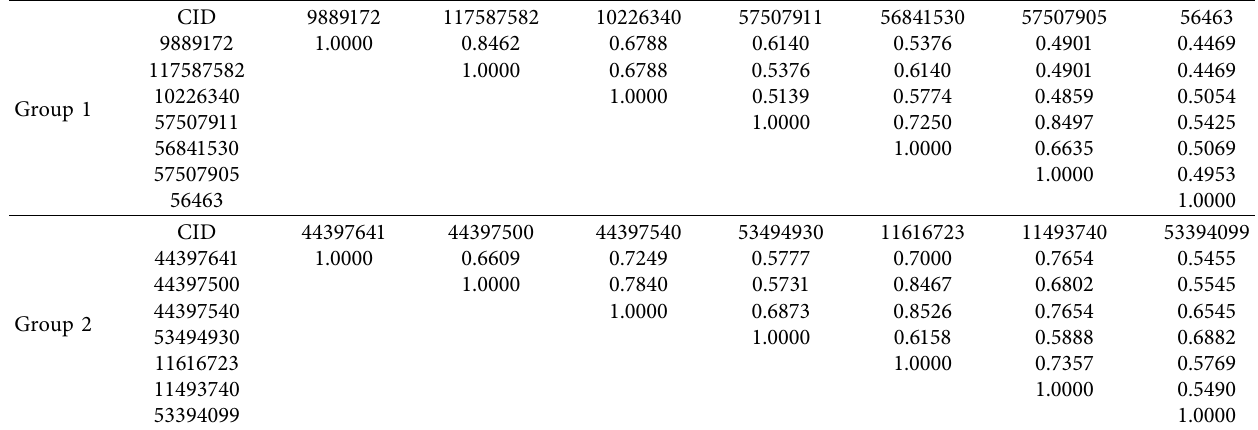
Table 3: Tanimoto coefficients for the atoms similarity.